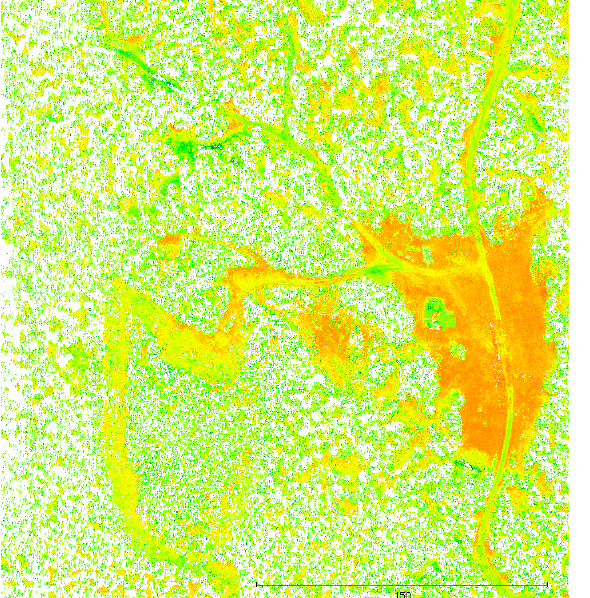
Figure 2. Low-cost ALS data, Eastern Abertamy mining site, point cloud density